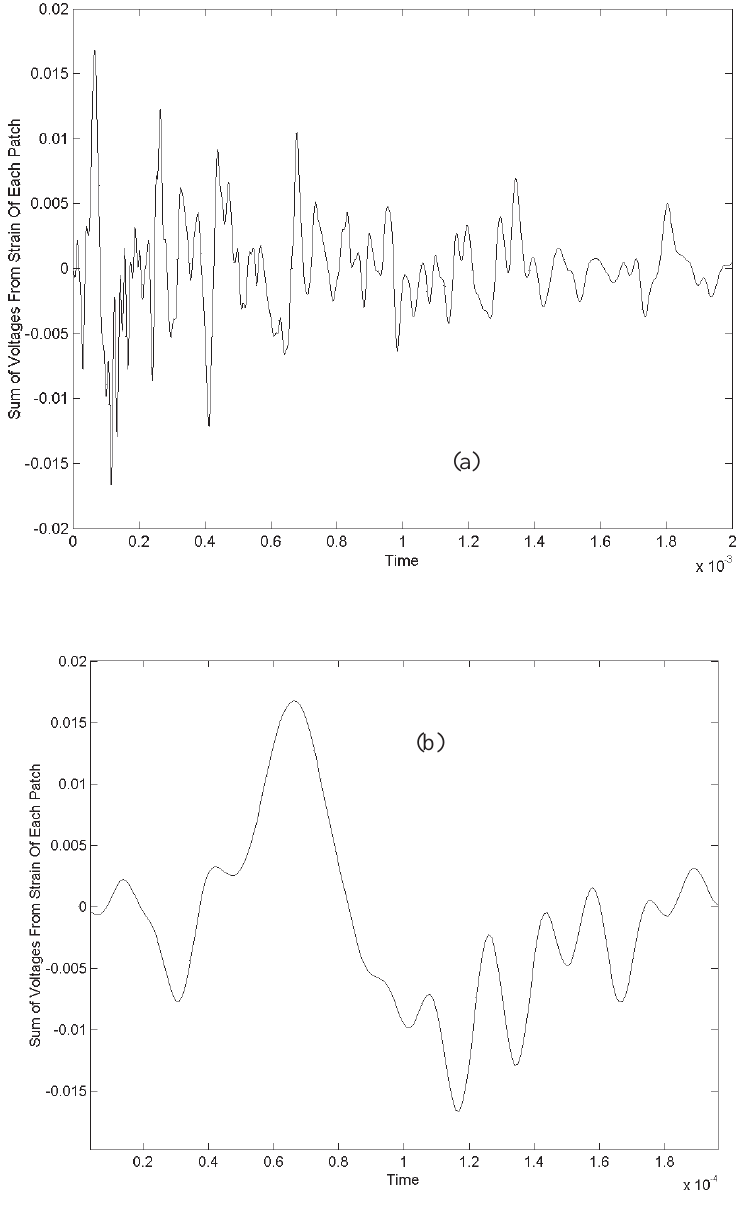
Fig. 10. Voltage time history due to edge actuation by a PZT patch; (a) continuous sensor voltage for 2 ms, (b) continuous sensor voltage for 0.2